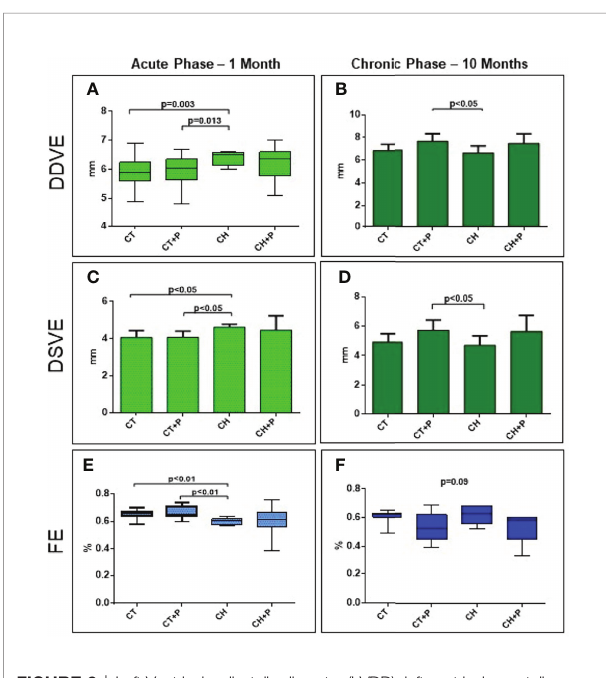
FIGURE 2 | Left Ventricular diastolic diameter (LVDD), left ventricular systolic diameter (LVSD) and left ventricular ejection fraction (EF). (A) LVDD in the acute phase (n=62); (B) LVDD in the chronic phase (n=33). (C) LVSD in the acute phase (n=62); (D) LVSD in the chronic phase (n=33), (E) EF in the acute phase (n=62); (F) EF in the chronic phase (n=33). CT - control group, CT+P – control group exposed to pollution, CH – chagasic group, CH+P – chagasic group exposed to pollution.